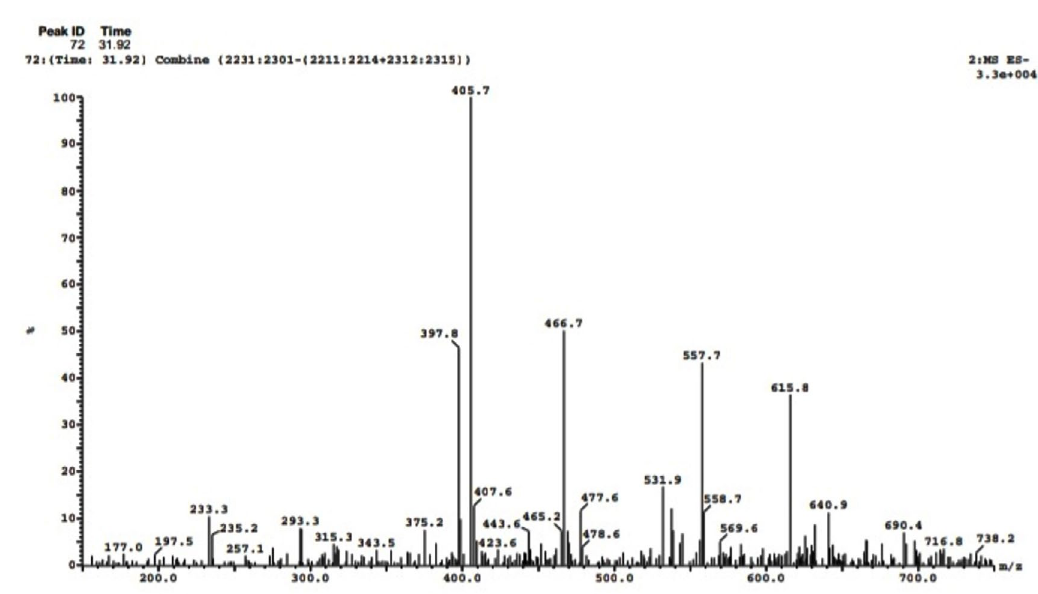
Fig. 6 (v). Mass spectrum at the retention time